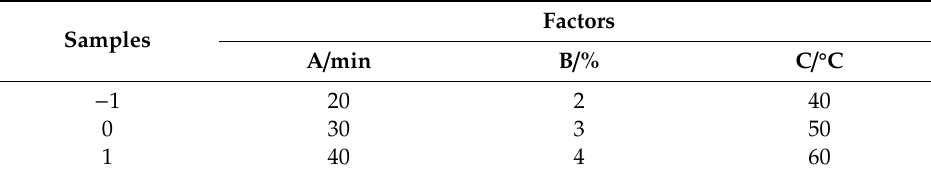
Table A1: Response surface analysis and level design, Table A2: Response surface design and experimental results. Table A1. Response surface analysis and level design.